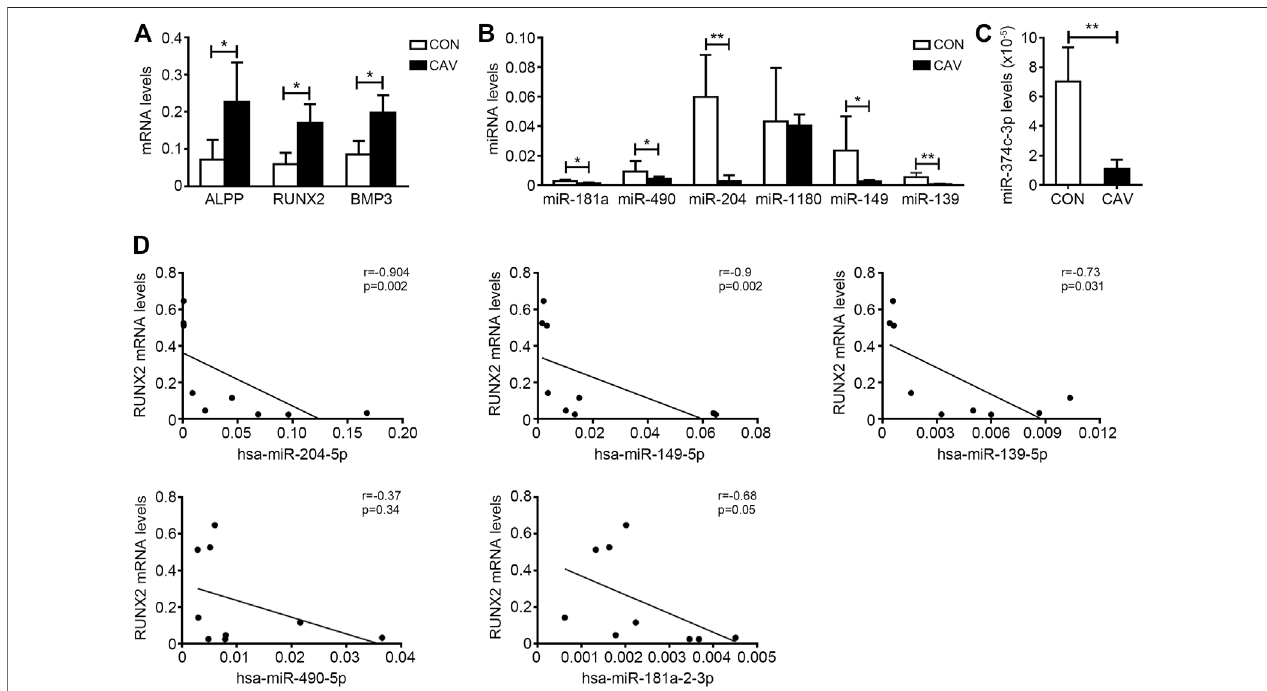
FIGURE3| Theveri fi cationofdownregulatedcandidatemiRNAs incalci fi edaorticvalves. (A) Theexpression levelsofosteogenicgenes ALPP , RUNX2 and BMP3 in valves from CON patients ( n (cid:2) 5 biologically independent samples) and CAV patients ( n (cid:2) 4 biologically independent samples) were accessed by qRT-PCR and normalized with GAPDH . (B,C) The expression levels of hsa-miR-181a-2-3p (miR-181a), hsa-miR-490-5p (miR-490), hsa-miR-204-5p (miR-204), hsa-miR-1180-3p (miR-1180), hsa-miR-149-5p (miR-149), hsa-miR-139-5p (miR-139) (B) and hsa-miR-374c-3p (C) in valves from CON patients ( n (cid:2) 5 biologically independent samples) and CAV patients ( n (cid:2) 4 biologically independent samples) were accessed by qRT-PCR and normalized with U6. (D) Spearman ’ s correlation test was used to analyzethecorrelationoftheexpressionofhsa-miR-204-5p,hsa-miR-149-5p,hsa-miR-139-5p,hsa-miR-181a-2-3pandhsa-miR-490-5pwiththeexpressionlevelsof RUNX2 in aortic valves. Unpaired Student ’ s t -test, * p < 0.05, ** p < 0.01. CON, control; CAV, calci fi ed aortic